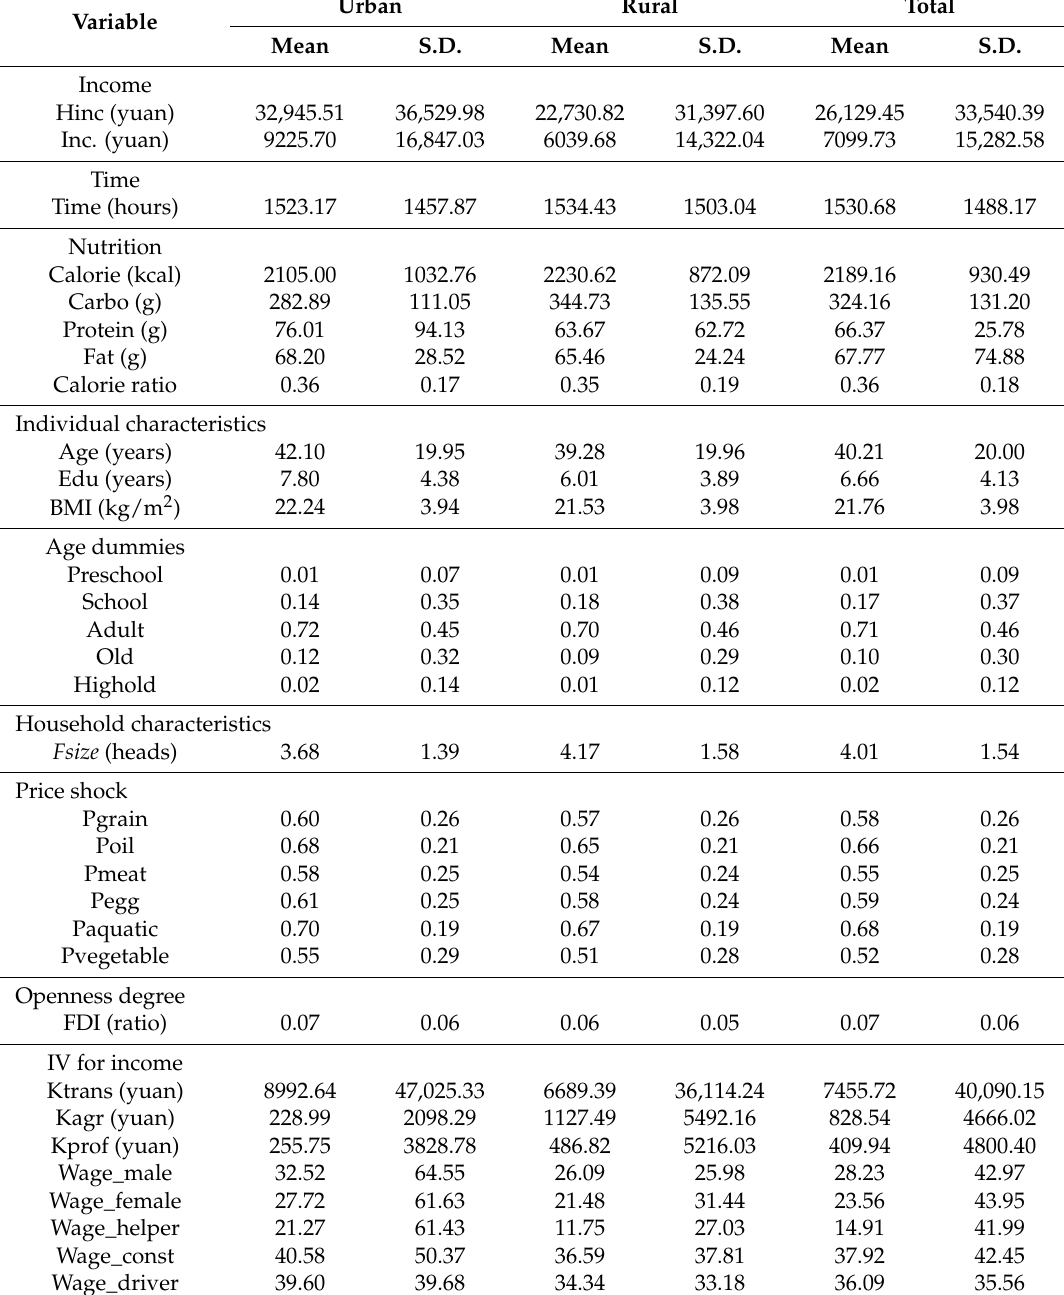
Table 2. Variables define and descriptive